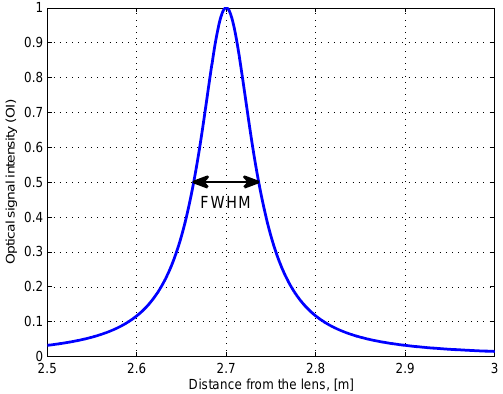
Figure 2. Optical signal intensity as a function of distance from the output lens of a telescope. For an effective aperture diameter of 2cm, the FWHM at a focus distance of 2.7m is about 72mm. Due to beam truncation at the output lens in our system, the measured FWHM is